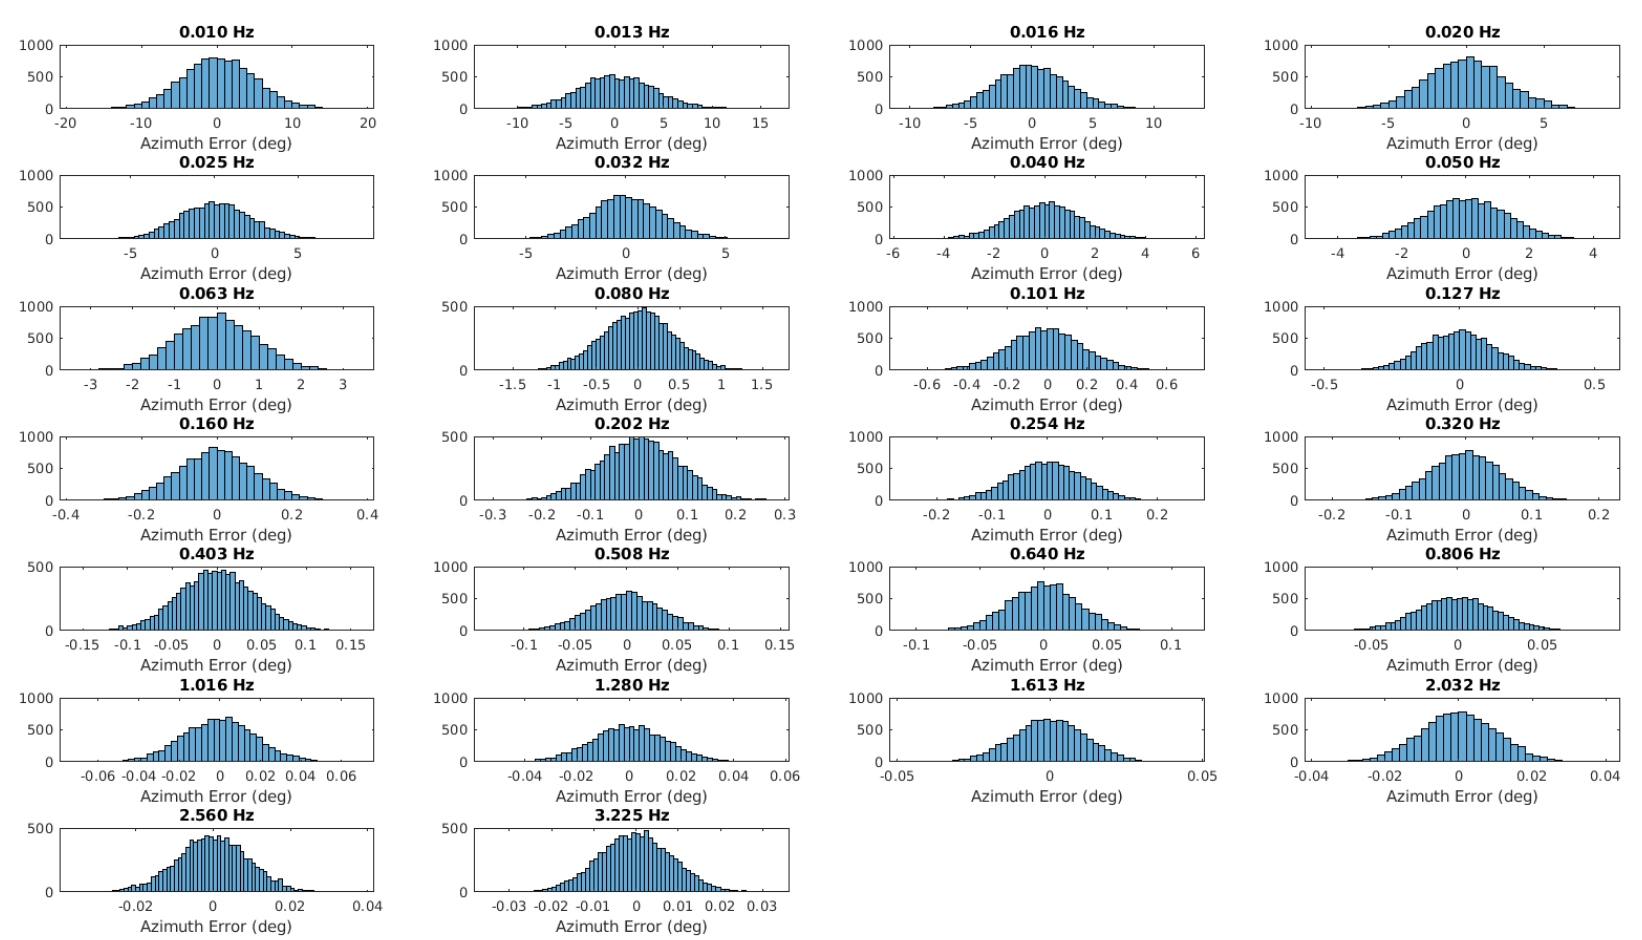
Figure A1. Back azimuth error (bias), SNR = Inf, M = 10 4